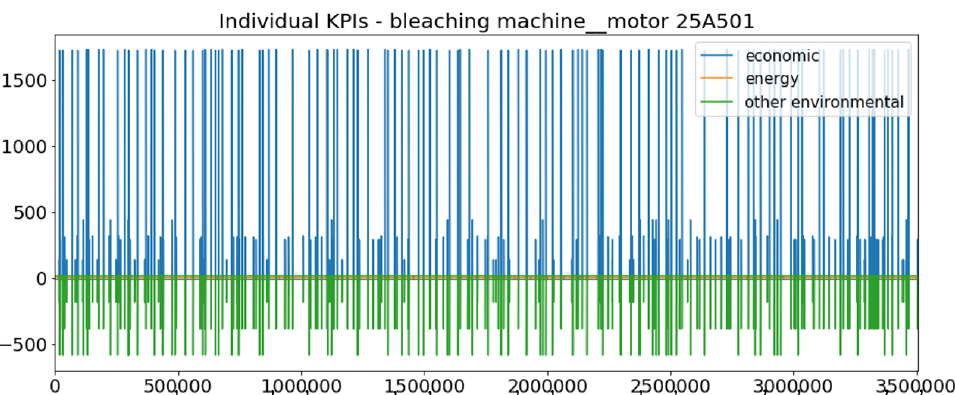
Figure 22. Individual KPI time series for the motor yielded from running the model with standalone uncoated roller for the bleaching machine (ZORLUTEKS). The simulation interval has the same length as for training (200